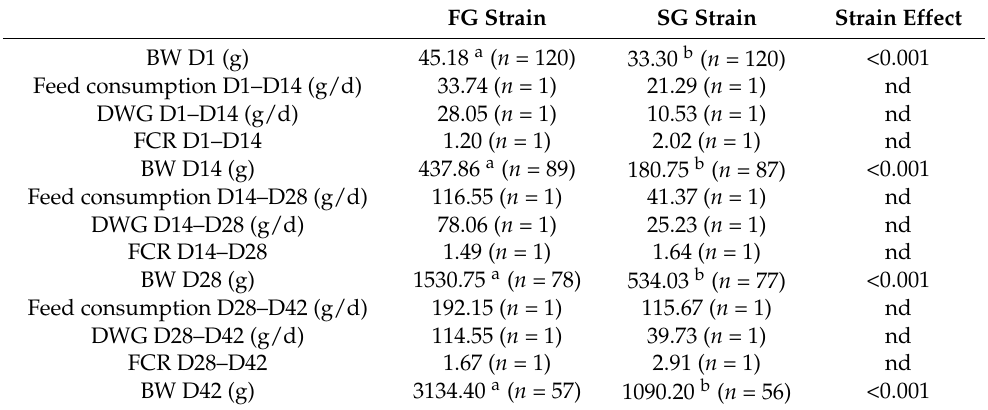
Table 3. Growth performance of chickens from the fast (FG) and slow growth (SG) rate strains. FG Strain SG Strain Strain